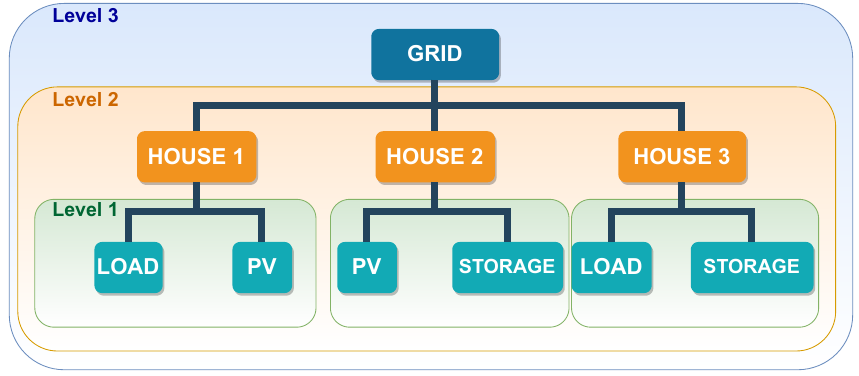
Figure 5. The hierarchical market